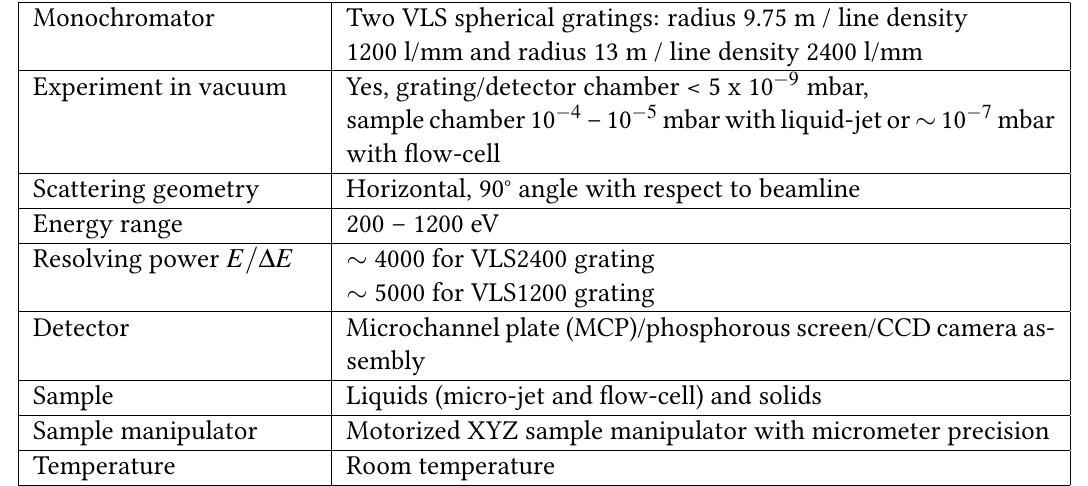
Table 1: Technical parameters of the LiXEdrom